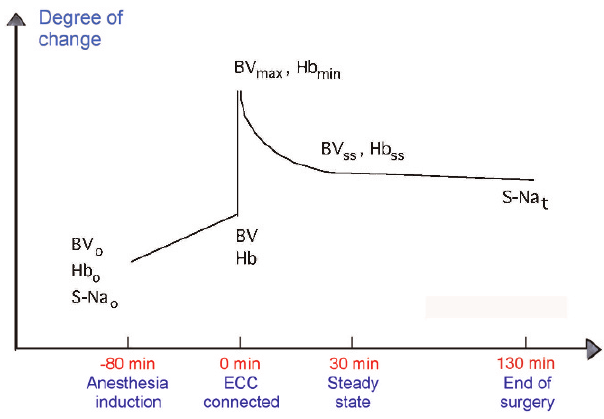
Figure 2 - Distribution of fluid after one patient was connected to the extracorporeal